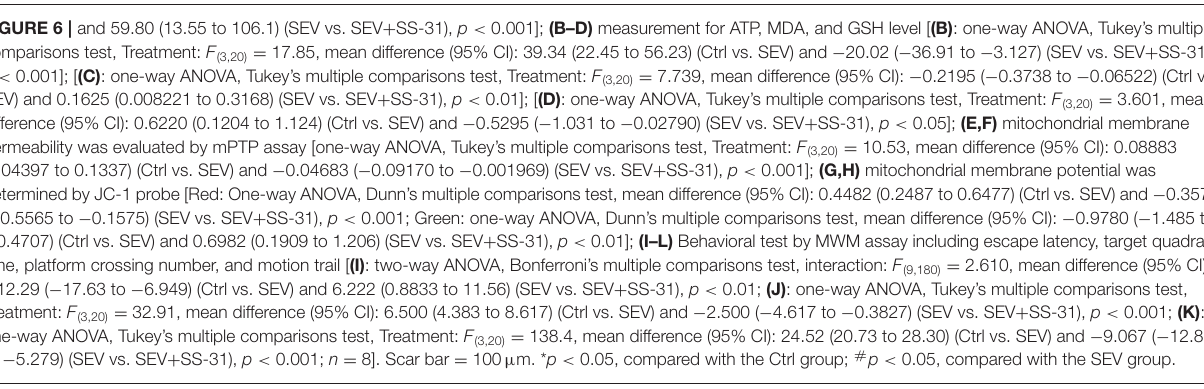
FIGURE 6 | and 59.80 (13.55 to 106.1) (SEV vs. SEV + SS-31), p < 0.001]; (B–D) measurement for ATP, MDA, and GSH level [ (B) : one-way ANOVA, Tukey’s multiple comparisons test, Treatment: F (3,20) = 17.85, mean difference (95% CI): 39.34 (22.45 to 56.23) (Ctrl vs. SEV) and − 20.02 ( − 36.91 to − 3.127) (SEV vs. SEV + SS-31), p < 0.001]; [ (C) : one-way ANOVA, Tukey’s multiple comparisons test, Treatment: F (3,20) = 7.739, mean difference (95% CI): − 0.2195 ( − 0.3738 to − 0.06522) (Ctrl vs. SEV) and 0.1625 (0.008221 to 0.3168) (SEV vs. SEV + SS-31), p < 0.01]; [ (D) : one-way ANOVA, Tukey’s multiple comparisons test, Treatment: F (3,20) = 3.601, mean difference (95% CI): 0.6220 (0.1204 to 1.124) (Ctrl vs. SEV) and − 0.5295 ( − 1.031 to − 0.02790) (SEV vs. SEV + SS-31), p < 0.05]; (E,F) mitochondrial